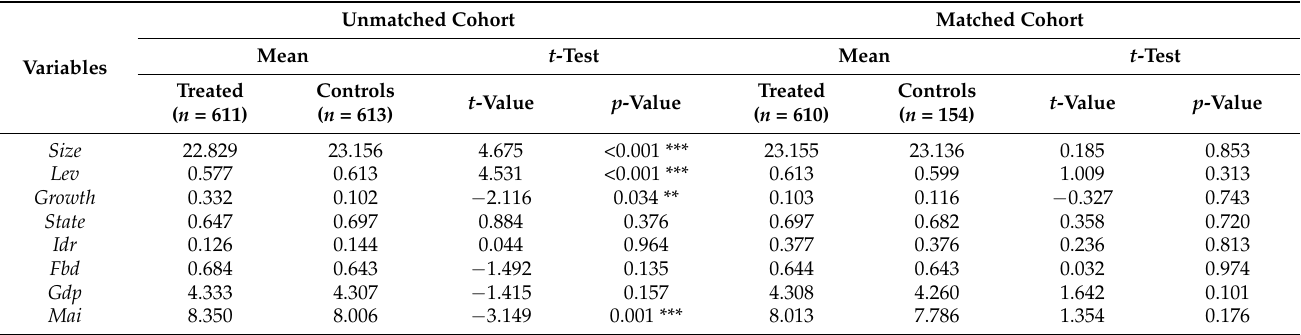
Table 2. Results of the balance test after propensity score matching.